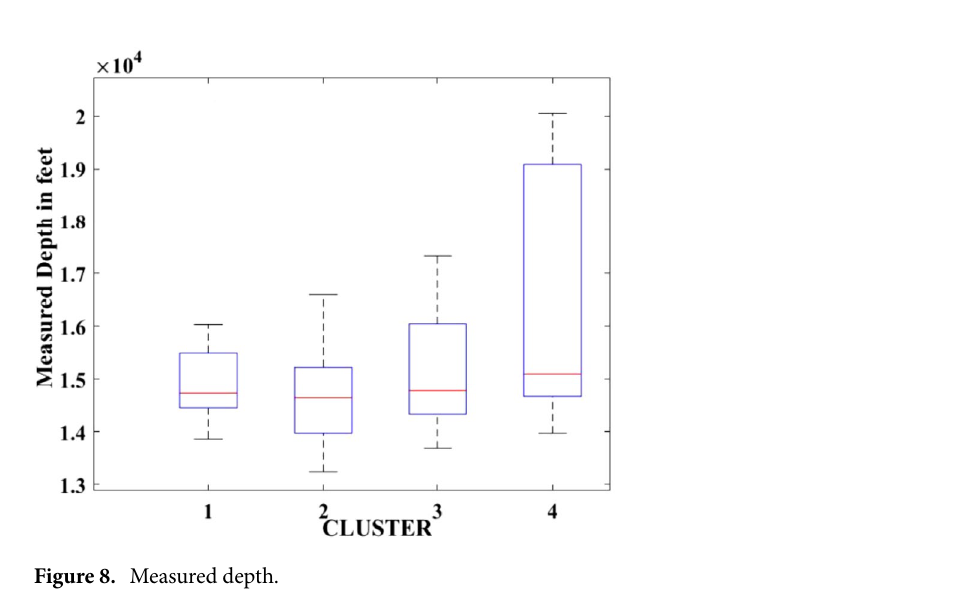
Figure 7. TVD heel-toe difference.